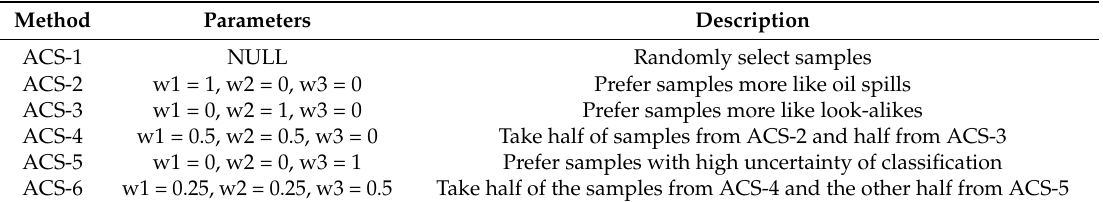
Table 3. Six basic active sample selecting (ACS) methods.